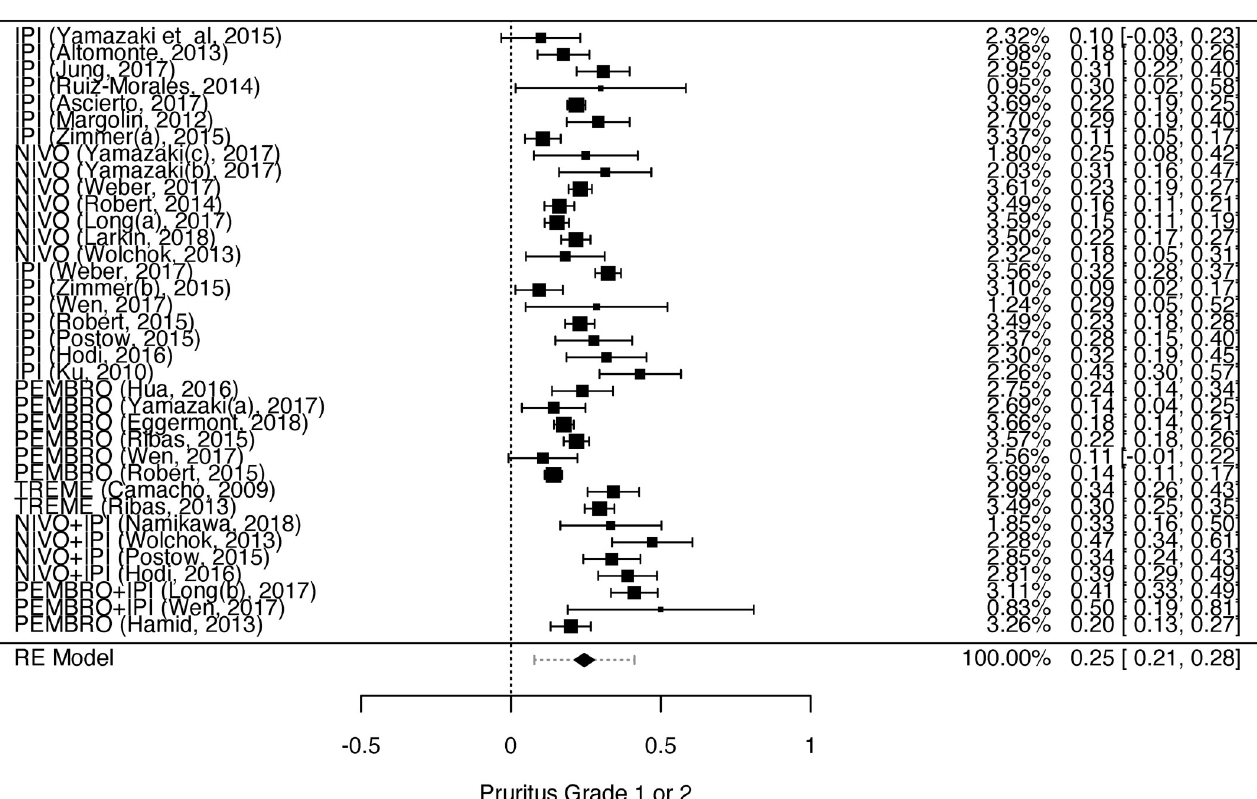
Fig 3. Meta-analysis of pruritus outcome grade 1 or 2. Elaborated by the authors using JAMOVI 1 . Legend: IPI—Ipilimumab, NIVO—Nivolumab, PEMBRO —Pembrolizumab, TREME—Tremelimumab.